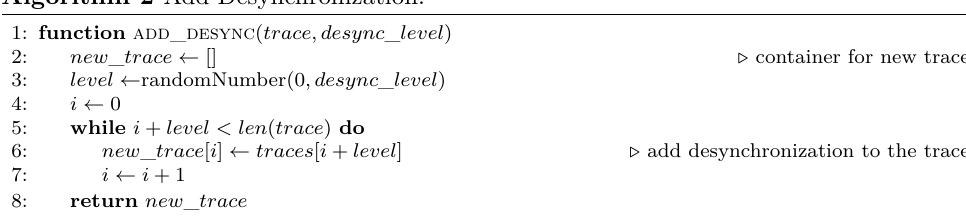
from a practical perspective. Even with an unprotected device, sometimes the traces synchronization can be a challenging